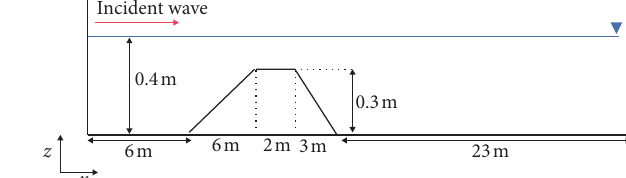
Figure 2: Schematic of the breakwater and flume.